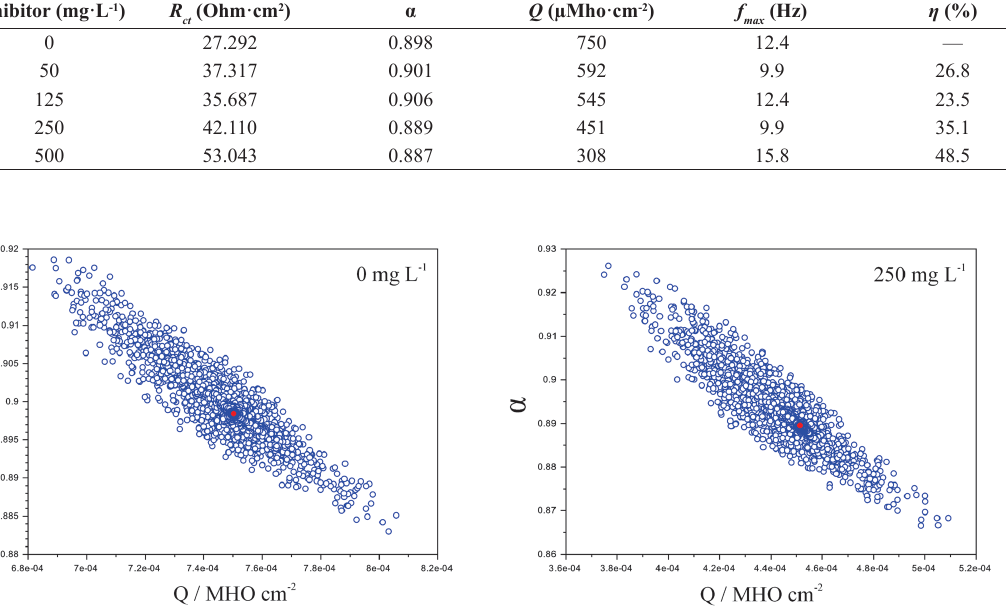
Figure 5: The 99% confidence region of Q and α obtained by differential evolution fit for EIS data of C‑steal in 1.0 mol·L -1 H absence and presence of 250 mg·L -1 of methanolic Bauhinia purpurea